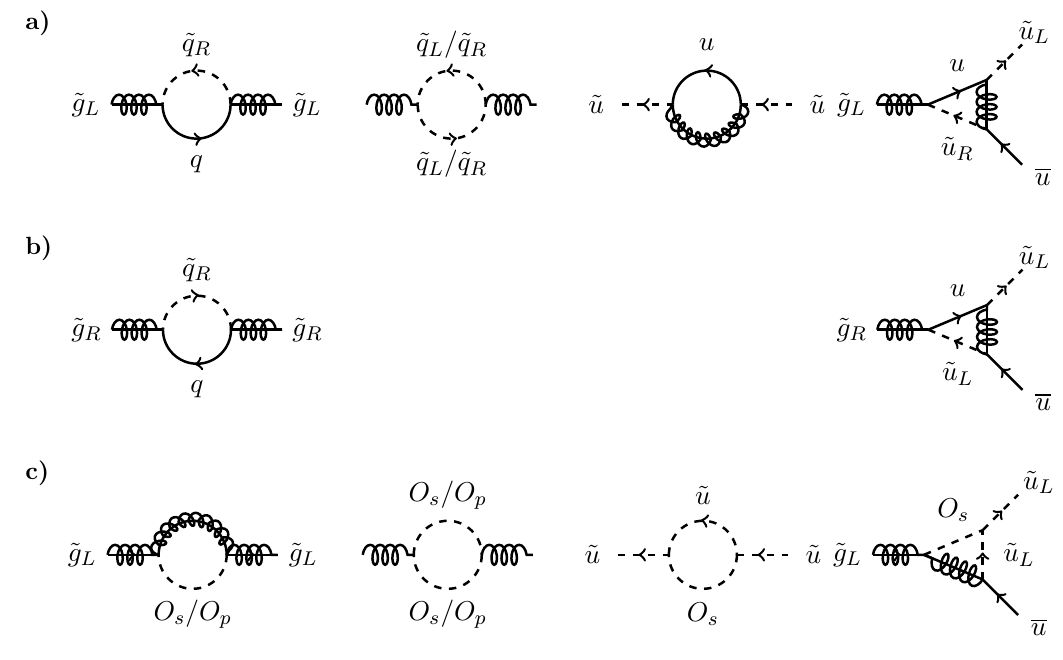
Figure 3. Examples of Feynman diagrams relevant for the calculation of the counterterms. Cate- gory a) diagrams are as in the MSSM. For comparison category b) contains diagrams which lead to contributions in the MSSM but not the MRSSM. Category c) are novel diagrams originating from the